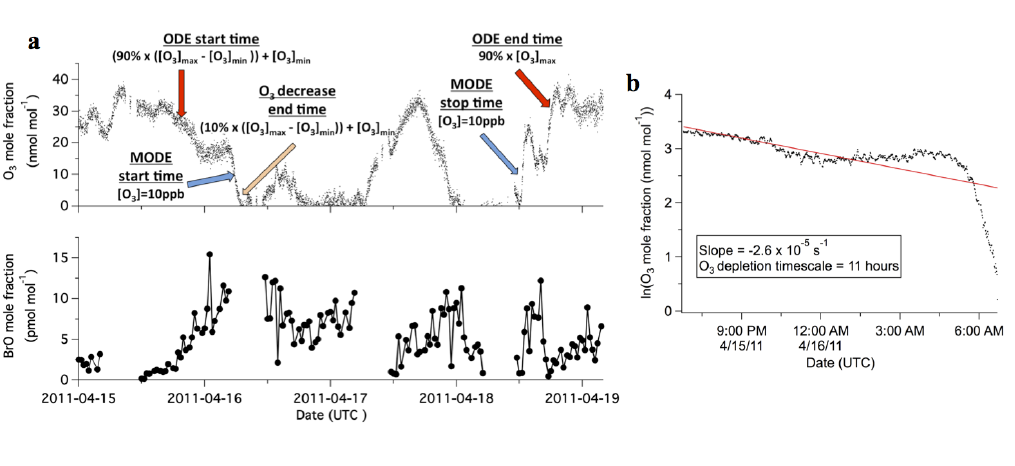
Figure 3. (a) Example ODE from O-Buoy2 deployment in the Beaufort Sea with ODE definitions illustrated. The brief resurgence of O 3 on 17 April does not rise above 25nmolmol − 1 for longer than 12h and is thus not considered as separating two ODEs. Error bars are not displayed to more clearly show the time series. As discussed in Sect. 2.1, individual measurement errors for O 3 ranged from 2.1 to 3.5nmolmol − 1 , and BrO measurement errors ranged from 0.7 to 6.9pmolmol − 1 (median and average error ∼ 3pmolmol − 1 ). (b) Example of O 3 depletion timescale calculation based on the depletion range (ODE start time – O 3 decrease end time) from (a) . The natural logarithm of the O 3 values is plotted against time, and the inverse slope of this plot represents the O 3 depletion timescale. range from 0.7 to 6.9 pmol mol − 1 , with average and